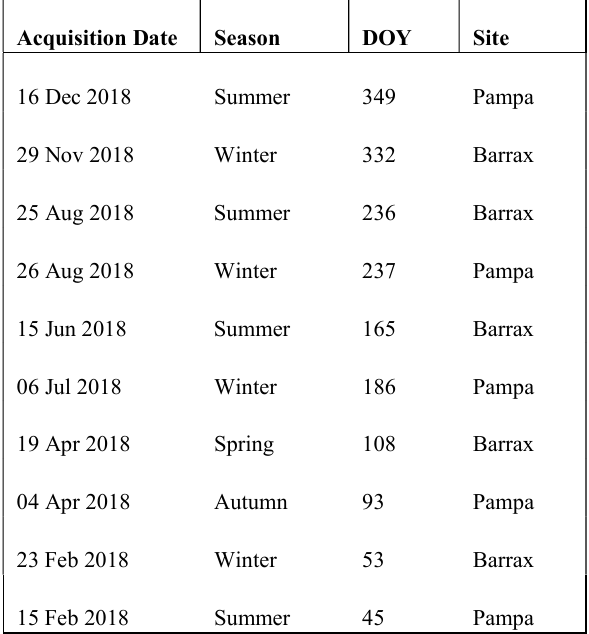
Table 1. Satellite Landsat 8 OLI/TIRS data by each day of year (DOY) to Pampa Biome